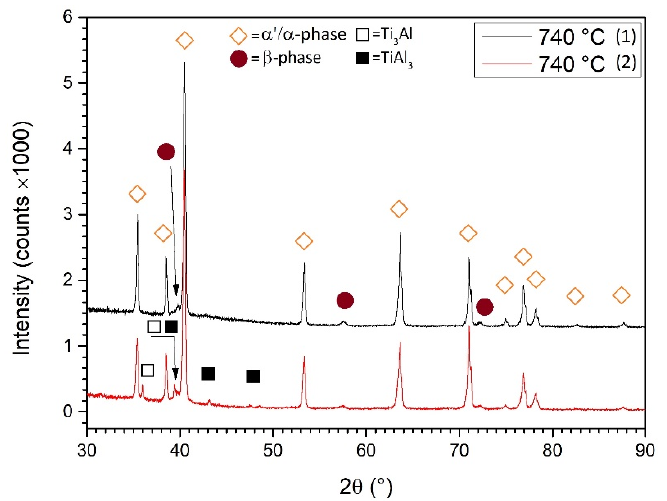
Figure 16. XRD patterns of two 90° Z -samples manufactured in the same batch and heat-treated at 740 °C/130 ′ . The black XRD pattern (1) is correlated to the red pattern (2) that is the same shown in Figure 8a.